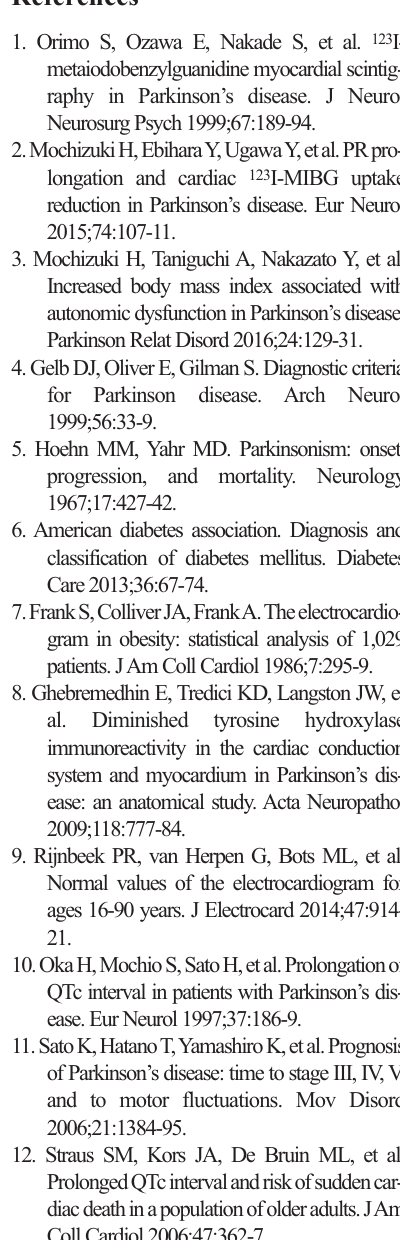
nomic dysfunction or disease progression. Clinicians should pay more attention to ECG parameters in the treatment of PD patients.